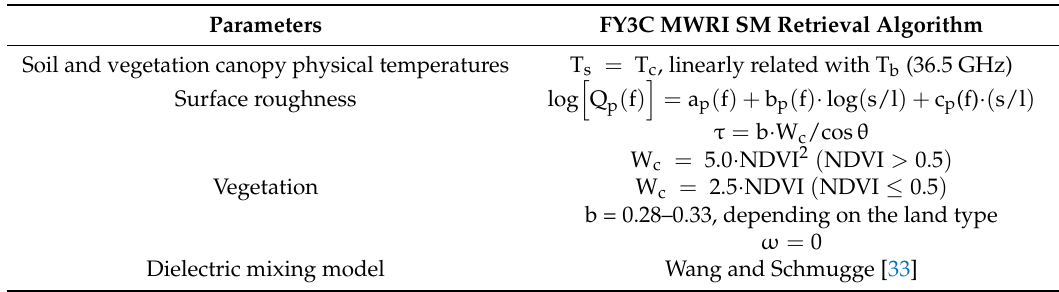
Table 3. Summary of the FY-3C soil moisture retrieval